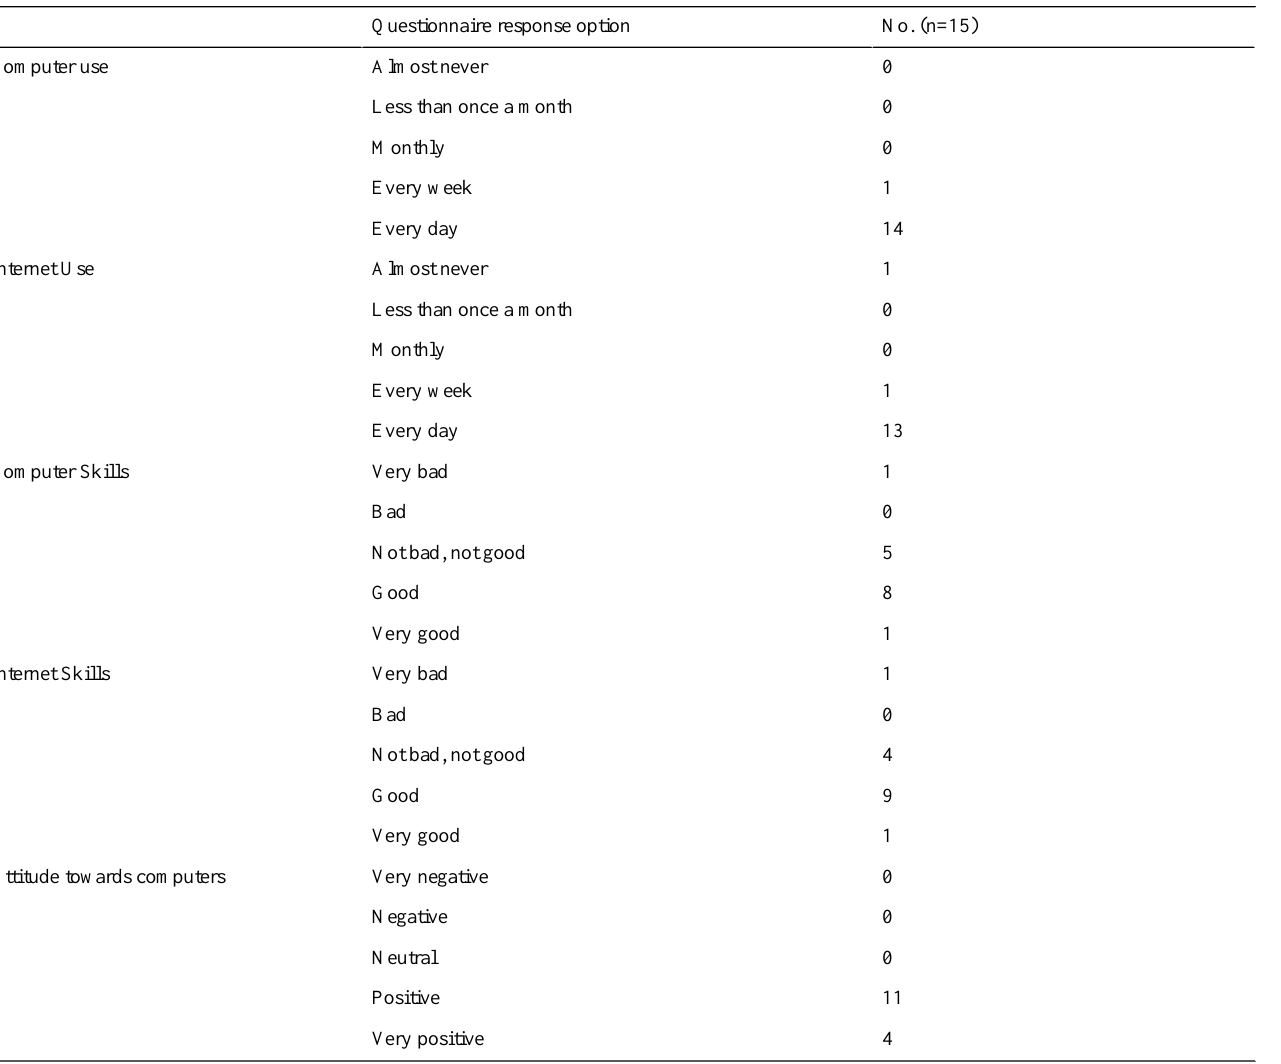
Table 2. Service users’computer and Internet use, skills and